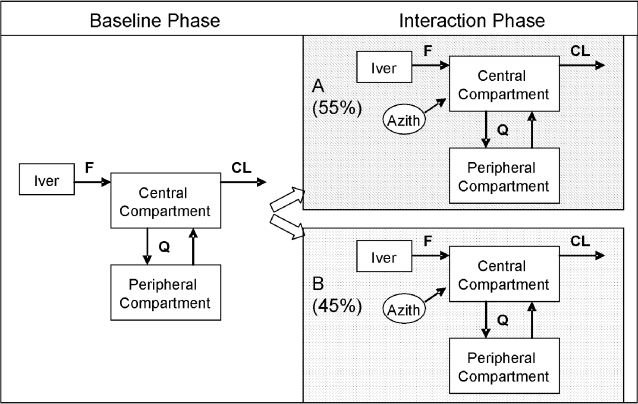
Two-compartment pharmacokinetic structural model for ivermectin.The best fit was obtained by models for two subpopulation (A and B), characterized by different F values, relative to the baseline model that included all subjects. Parameters: central and peripheral compartment volumes, total body clearance (CL), inter-compartmental clearance (Q), rate of absorption, and relative bioavailability (F). Note that albendazole was administered in both baseline and interaction phases.